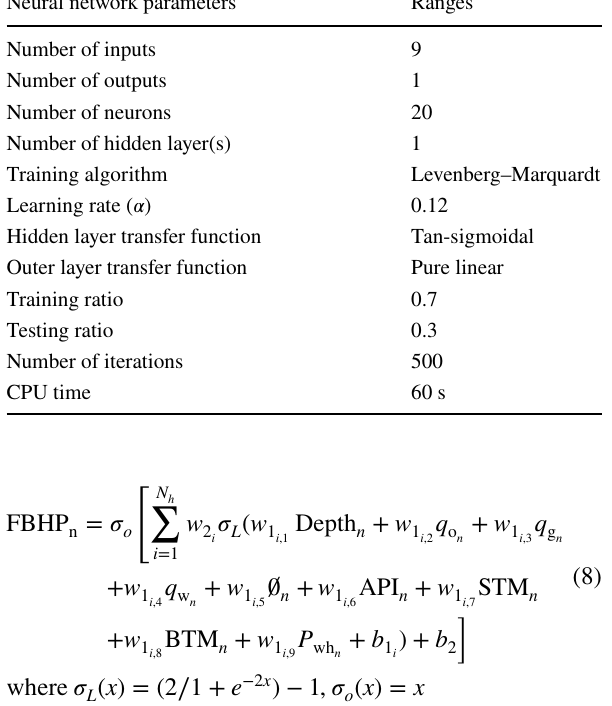
Table 5 PSO-optimized neural network architecture Neural network parameters